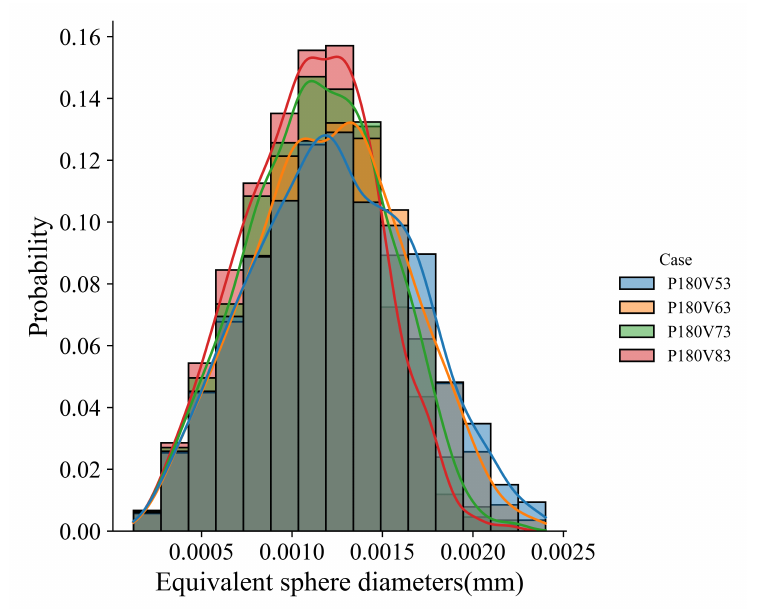
Figure 15. Grain size distributions for the cases with laser scan speed vary within the range of [0.53 m/s, 0.83 m/s] and the constant laser power of 180 W.